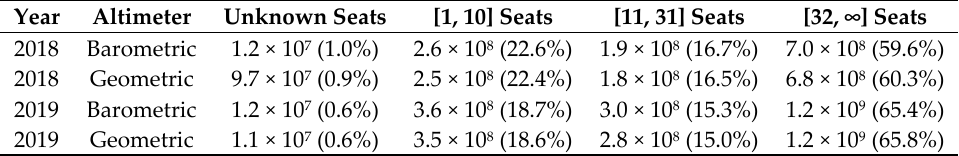
Table 2. Frequency of fixed wing multi-engine operating at or below 1200 feet AGL.